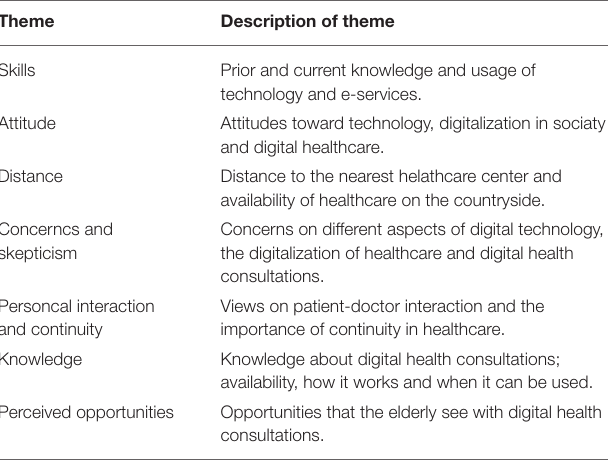
TABLE 1 | Three predefined themes (skills, attitude and distance) based on previous